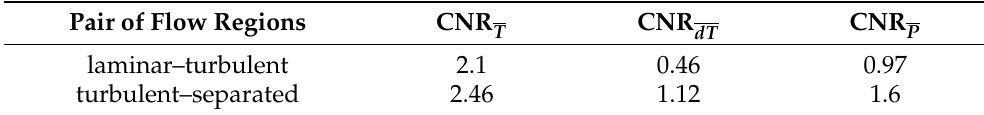
Table 1. Comparison of the contrast-to-noise ratio for the proposed signal processing approaches for a measuring object at near thermodynamic steady state: mean temperature CNR CNR , harmonic signal processing approach CNR dT